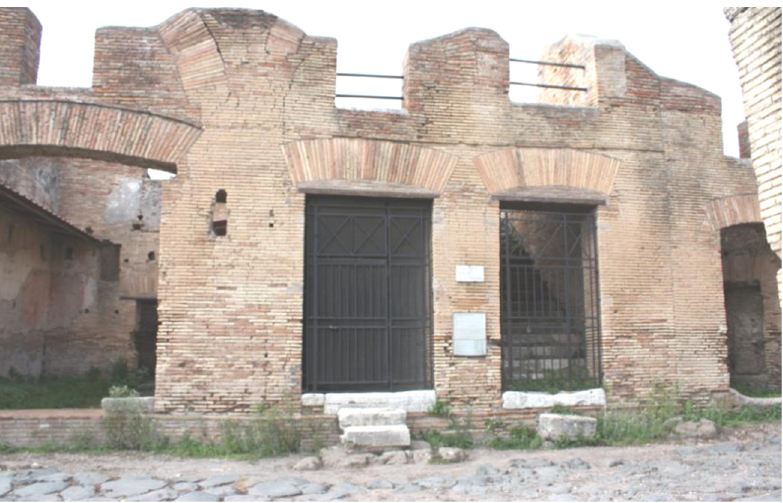
Figure 1. Principal entrance to the “Casa di Diana” Mithraeum . On the northwest side of the ground floor, two-room apartments ( Mithraeum and pre-Mithraeum ) of about 50 m 2 (27 m 2 per each room) are found. The pre-Mithraeum served as the proscenium of the Mithraic altar where such a kind of vessel ( dolium , an